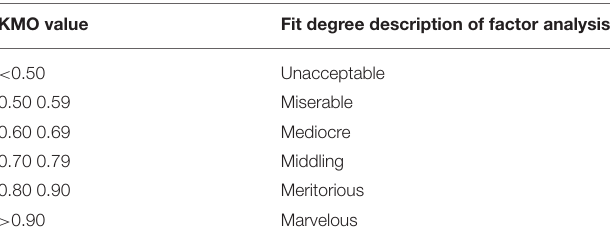
TABLE 5 | Evaluation principles of KMO.